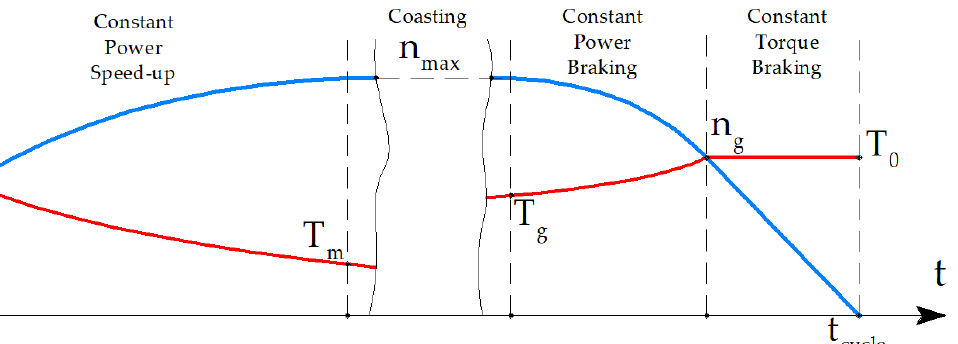
Figure 3. Sketch of the speed (blue) and torque (red) profiles in time of the traction motor of the subway train.